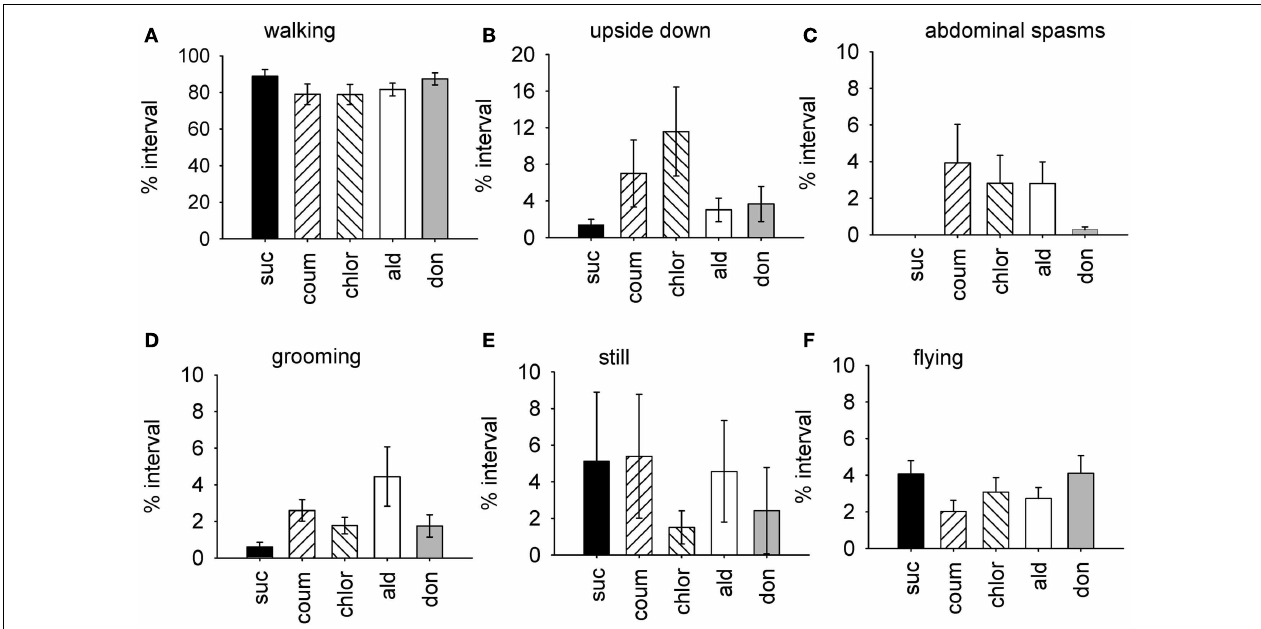
body grooming), (E) still, and (F) flying. Data is pooled from both indoor winter and outdoor summer bee colonies. N ≥ 23 individual bees for each treatment group. Suc, sucrose; Coum, coumaphos; Chlor, chlorpyrifos; Ald, aldicarb; Don, donepezil.